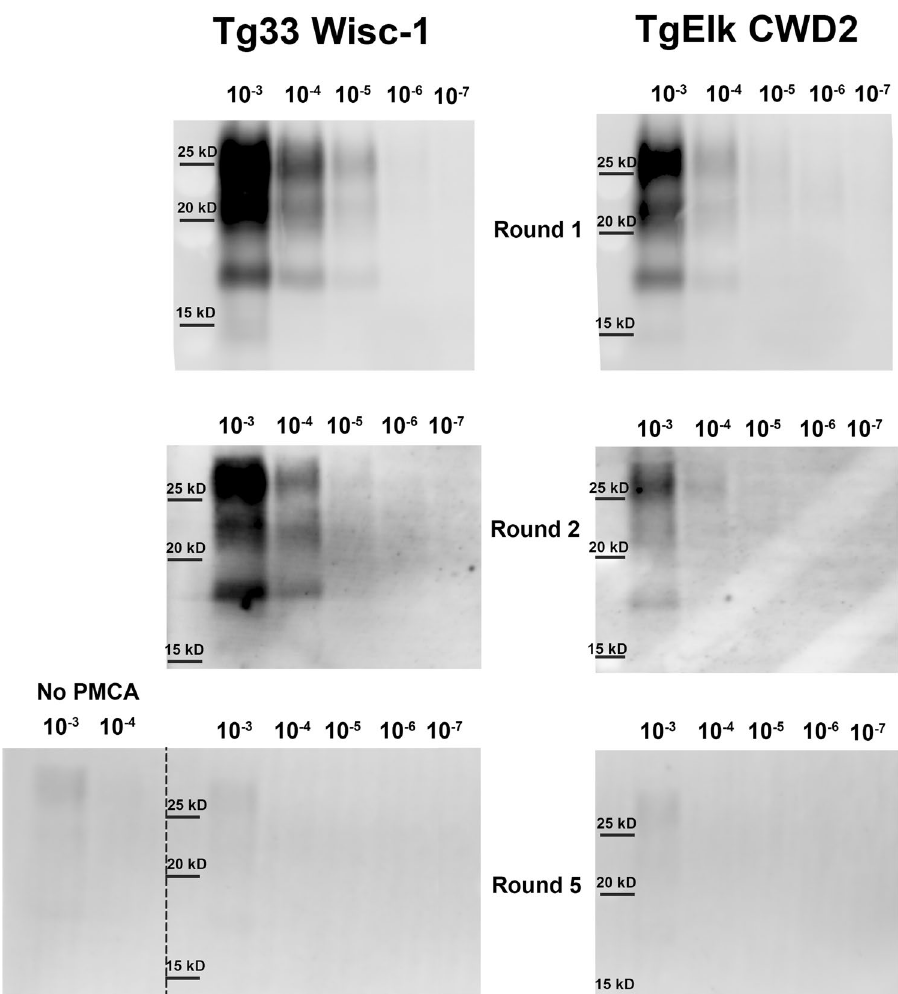
Figure 3. Serial PMCA amplification of tg33 Wisc-1 and tgElk CWD2 prions in S96-PrP C substrate. Serial dilutions (10 −3 to 10 −7 ) of brain homogenate from a tg33 mouse (expressing white-tailed deer wild-type PrP) infected with Wisc-1 CWD strain and a tgElk mouse (expressing elk PrP) infected with the CWD2 strain were serially propagated in the S96-PrP C brain substrate (tg60 mouse brain homogenate) for 5 rounds of PMCA. PMCA products were digested with PK (50 µg/ml) and analyzed by western blotting. Amplification efficiency of both strains was reduced in one log after two rounds of PMCA. After 5 rounds of PMCA no PrP CWD amplification in the S96 substrate is detected with neither of the strains. mAb Sha31